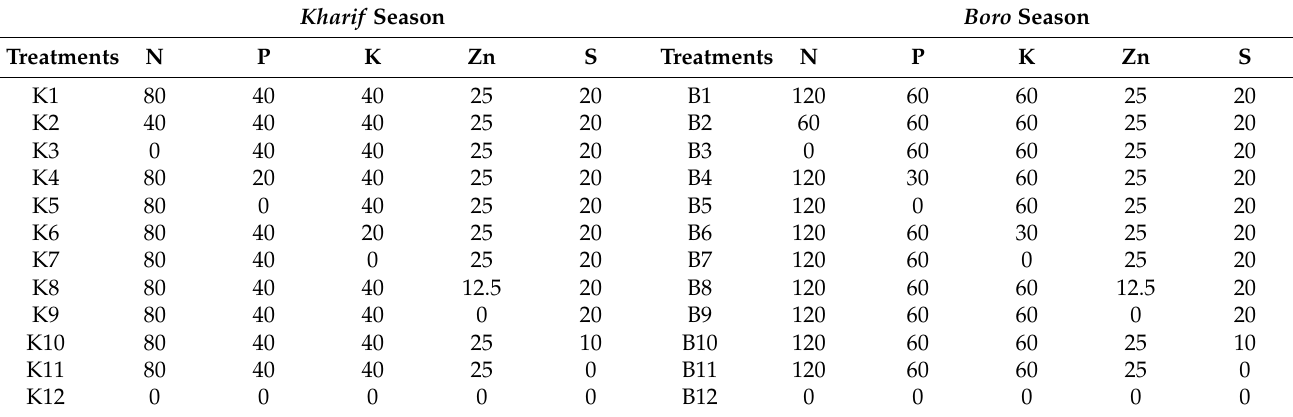
Table 3. Treatment combinations according to the recommended dose of fertilizers (RDF) (kg ha − 1 ).